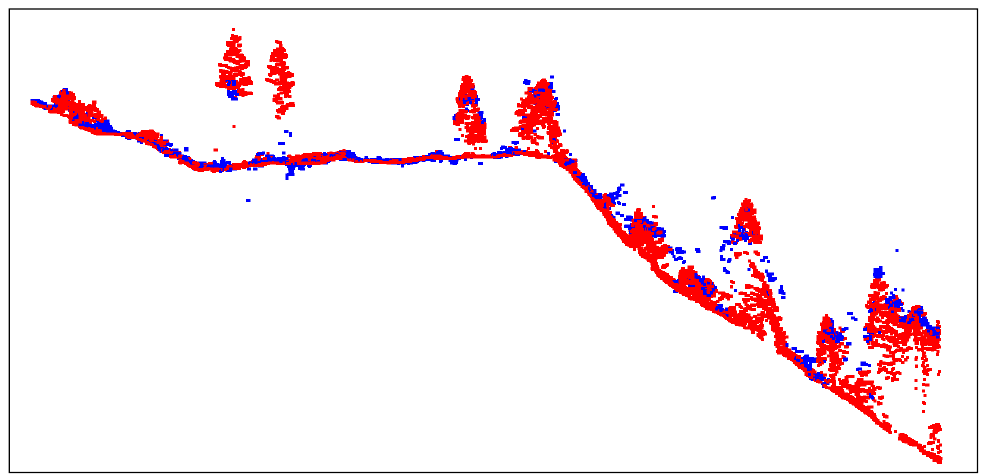
Figure 2. Example slice of lidar and photo-DSM point data, where the lidar is in red and the photo-DSM points are in blue. The slice is 3 m wide and 365 m long.